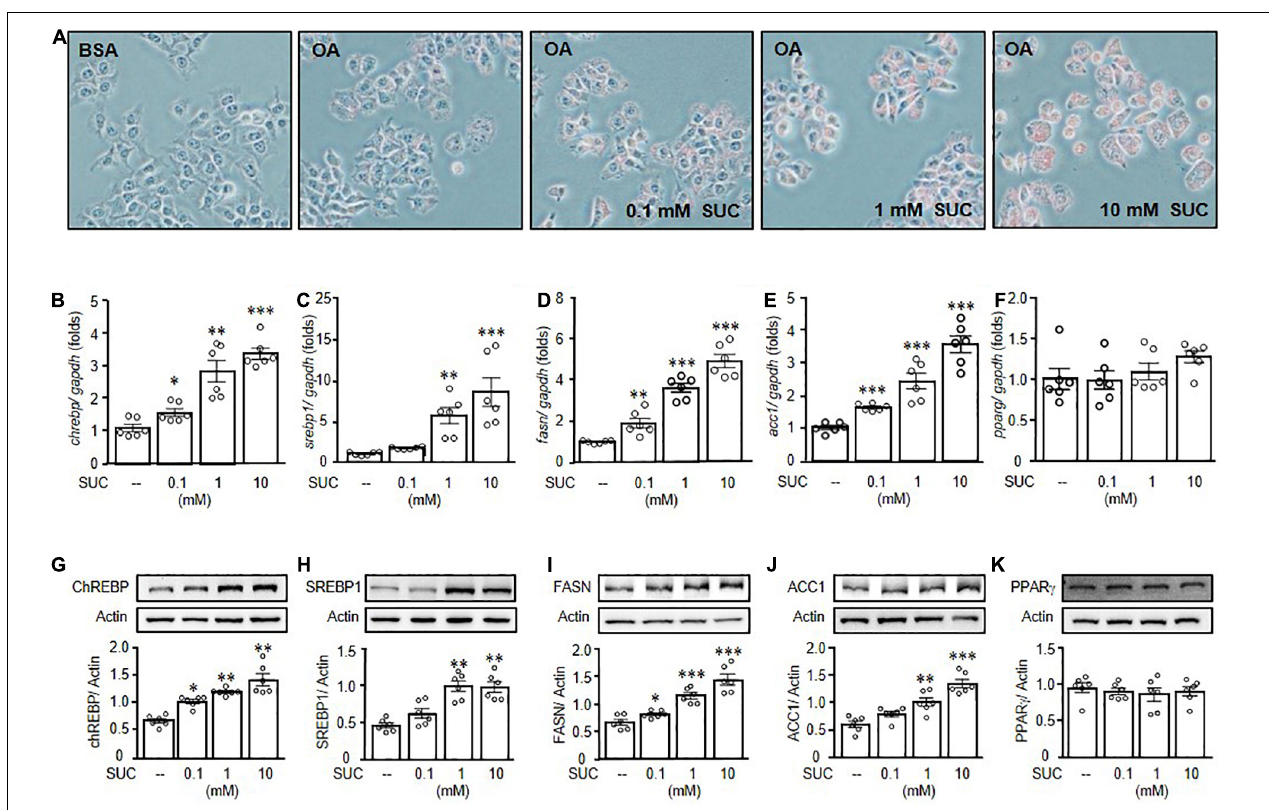
FIGURE 4 | Sucralose increased lipogenesis to facilitate lipid accumulation in HepG2 cells. HepG2 cells were pretreated with indicated doses of sucralose (SUC) for 24 h, and then treated with 0.5 mM oleic acid (OA) chelated with 2% bovine serum albumin (BSA) for another 24 h. Oil Red O staining was used to detect lipid accumulation (original magnification 200X) (A) . In addition, the gene (B–F) , and protein (G–K) expressions of carbohydrate-response element-binding protein (ChREBP), sterol regulatory element-binding protein 1 (SREBP1), fatty acid synthase (FASN), and acetyl-CoA carboxylase 1 (ACC1) were analyzed by real-time polymerase chain reaction and Western blots. Data are mean ± SEM ( n = 6 for each group) ∗ p < 0.05, ∗∗ p < 0.01, ∗∗∗ p < 0.001 as compared with control